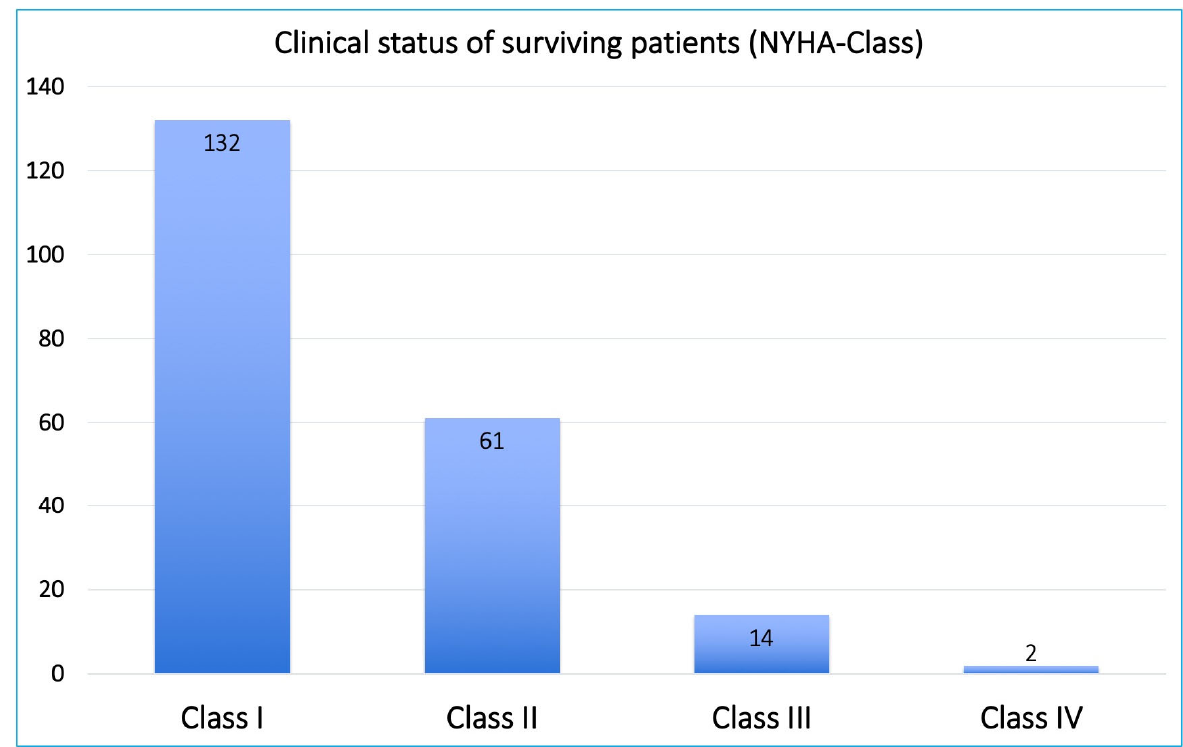
Figure 4. Chart bars showing the clinical status of surviving patients based on their NYHA class. Table 4. Long ‐ term clinical outcomes.